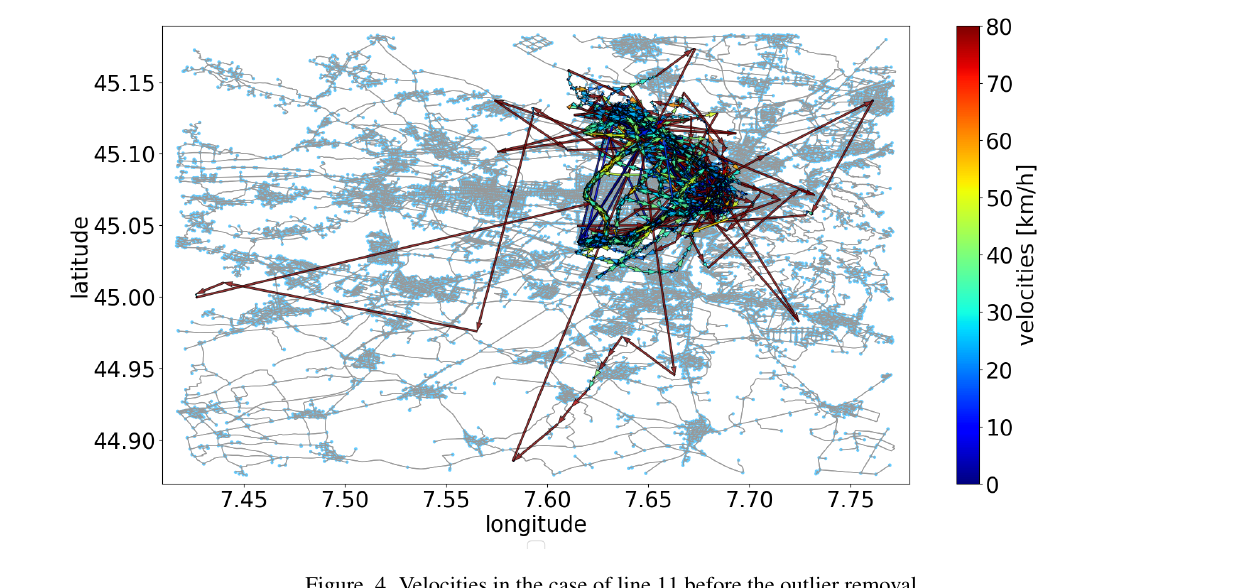
Figure 4. Velocities in the case of line 11 before the outlier removal.